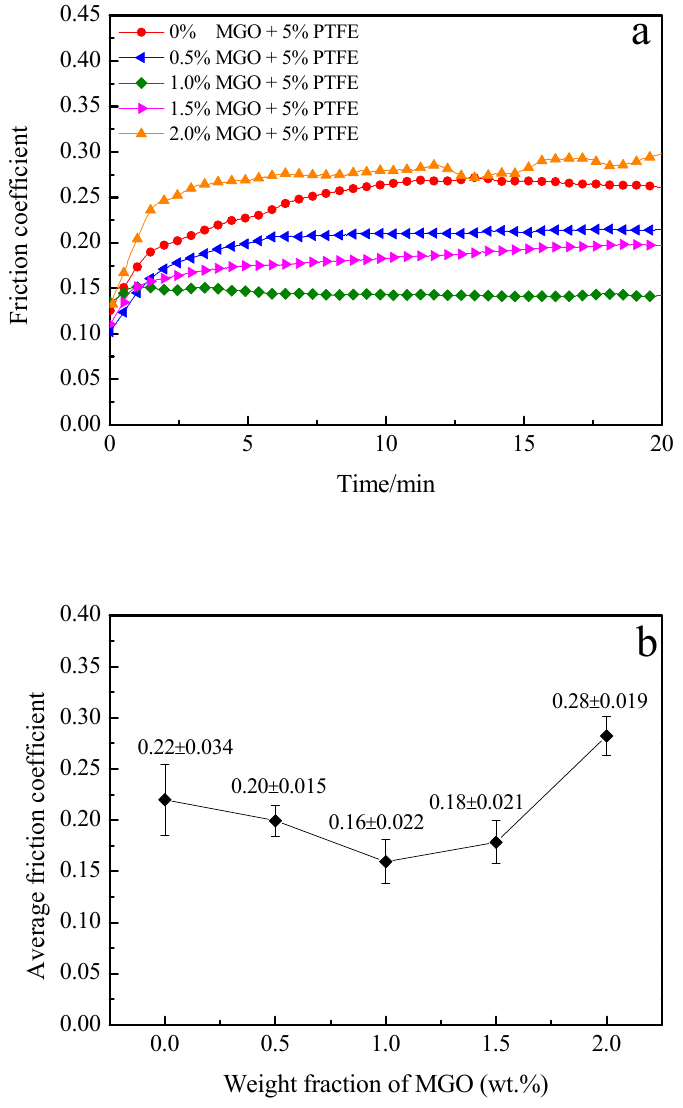
Figure 7. Friction coefficient of MGO-PTFE/WPU composite coating with different mass fractions of MGO, ( a ) real-time friction coefficient, ( b ) average friction coefficient. (Applied load is 6 N; test duration is 20 min)